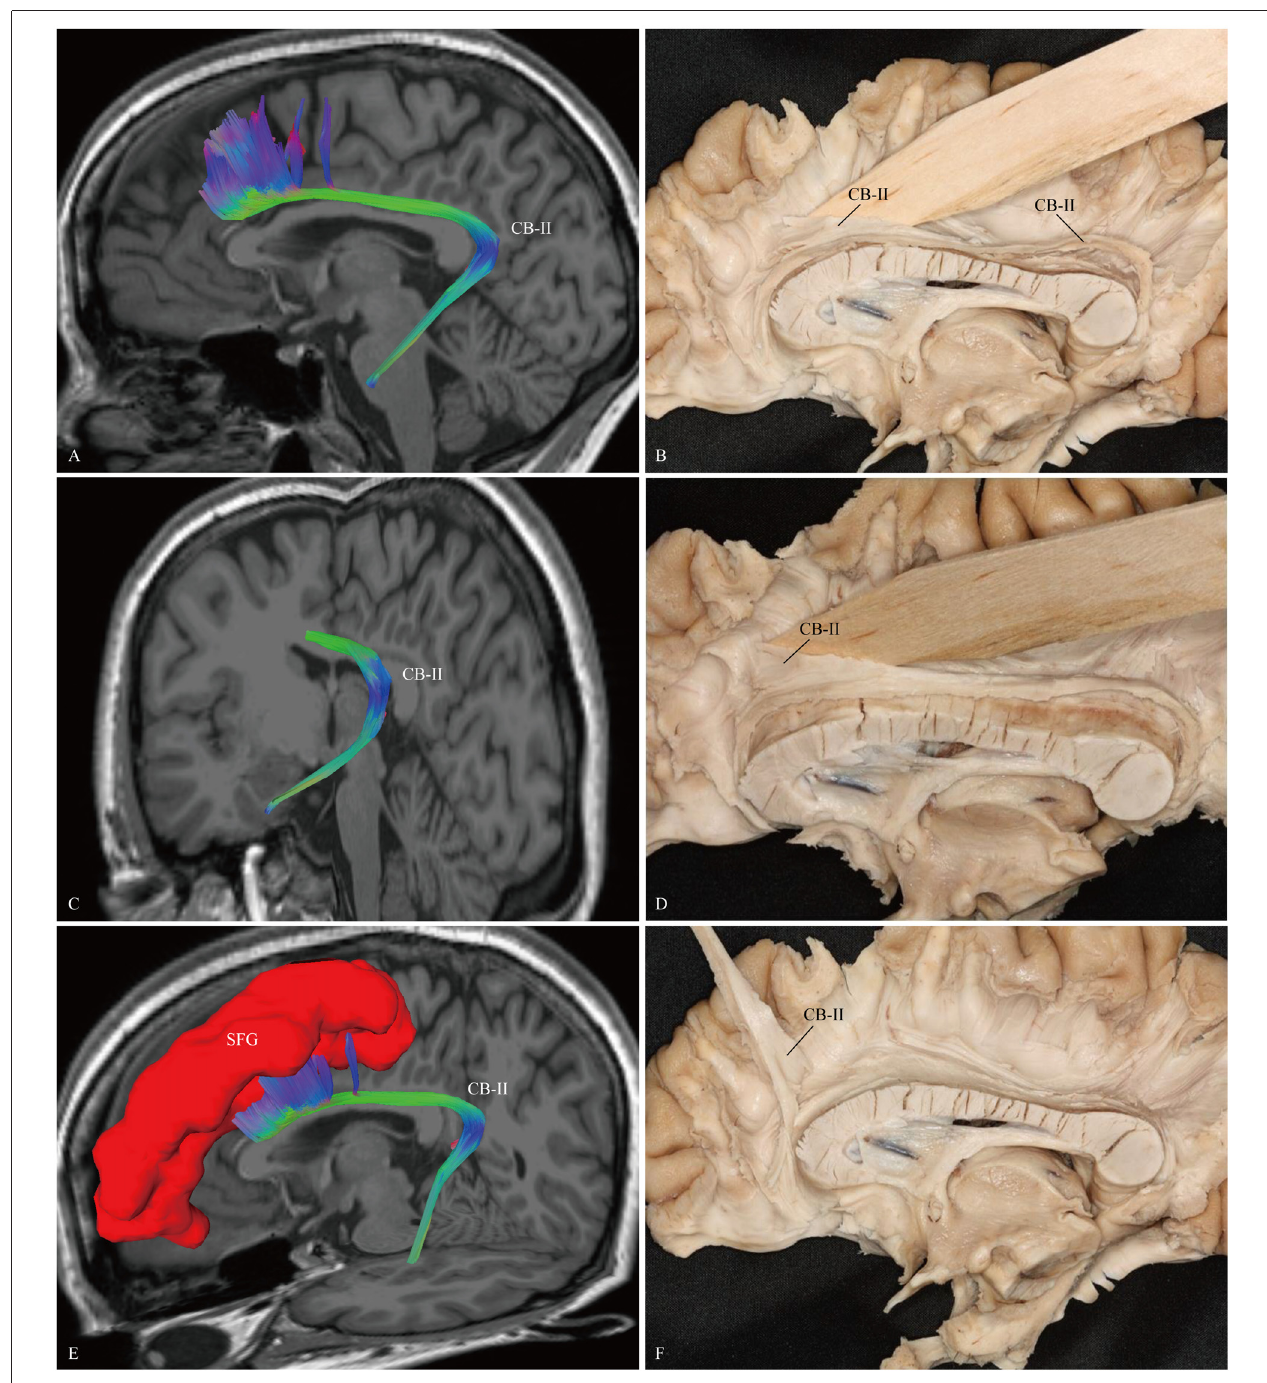
FIGURE 4 | In vivo fiber tractography and fiber dissection of the CB-II. (A–C) The CB-II originates from the para-hippocampal gyrus, arches around the splenium, then extends longitudinally above the CC. (D–F) The fibers continue anteriorly, lastly connect with the medial aspect of the SFG. SFG, superior frontal